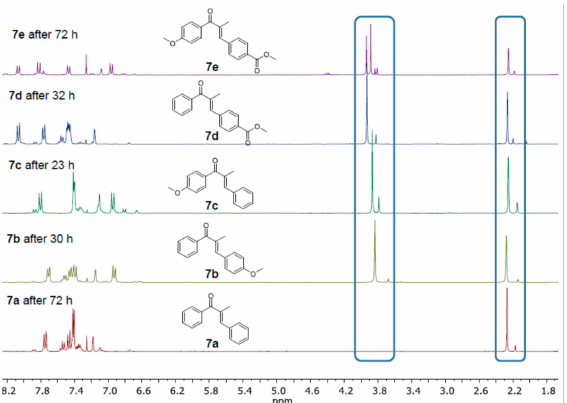
Figure 2. Photochemistry of α -methyl chalcones 7a – e under singlet oxygen reaction conditions (see experimental part for